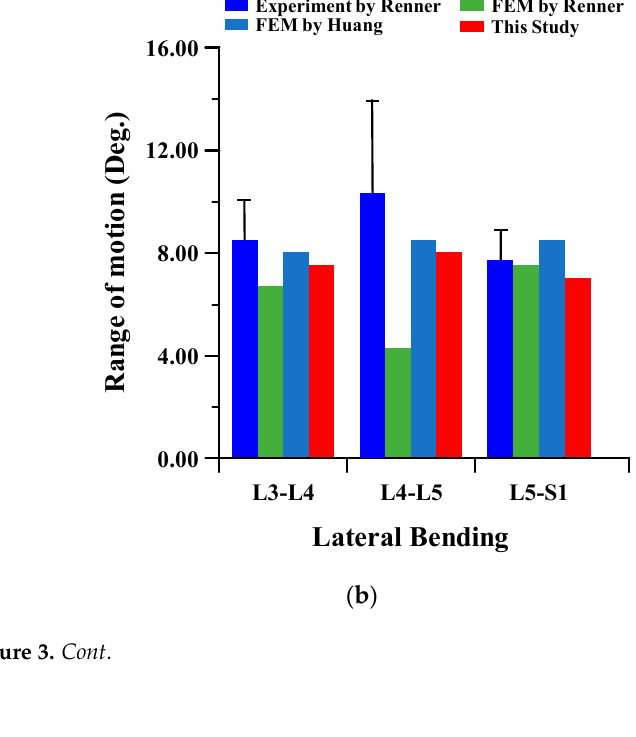
Figure 2. Loading and boundary conditions for simulation of six spinal motions: ( a ) flexion; ( b ) extension; ( c ) lateral bending; ( d )